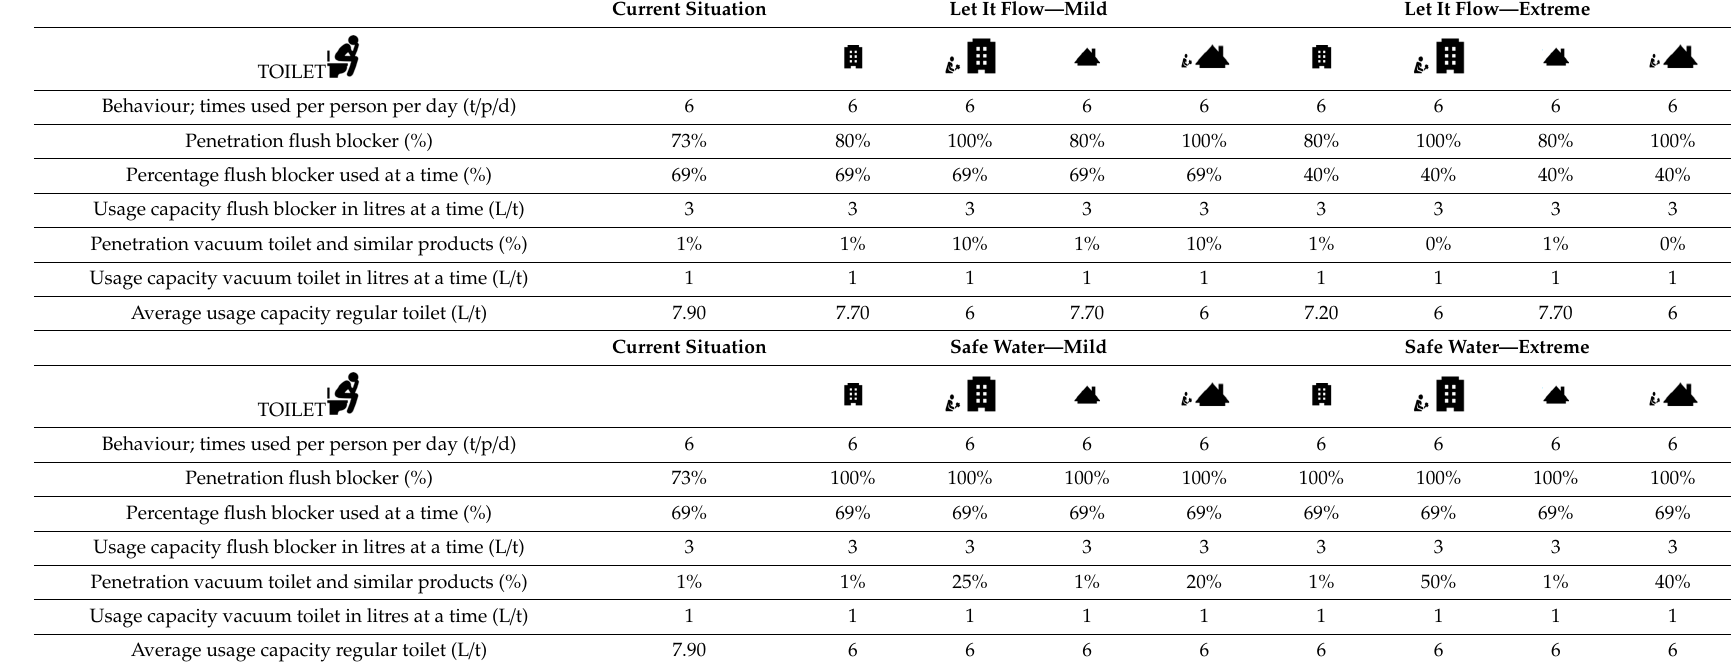
Table A3. Quantitative input data for individual water demands (STEP 6).